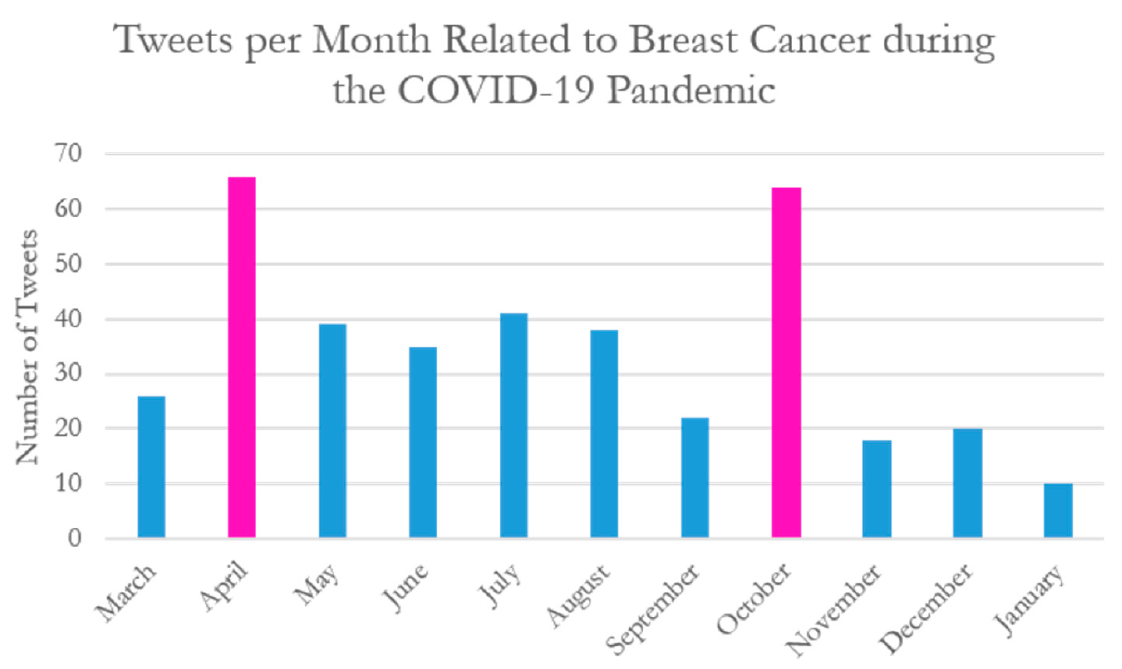
Figure 2. Tweets per month related to breast cancer during the COVID-19 Pandemic (March 2020–January 2021). Two peaks in the frequency of tweets occurred in April 2020 and October